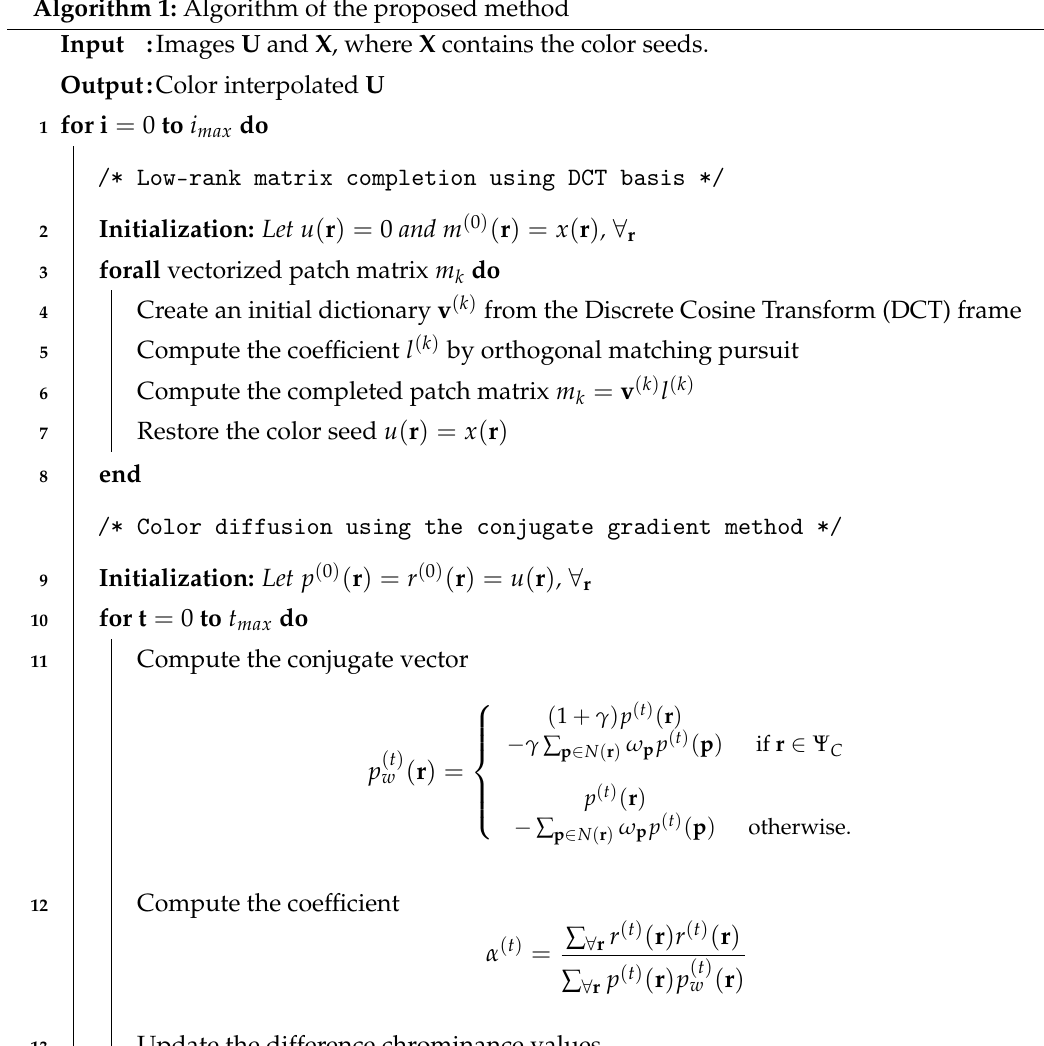
Algorithm 1: Algorithm of the proposed